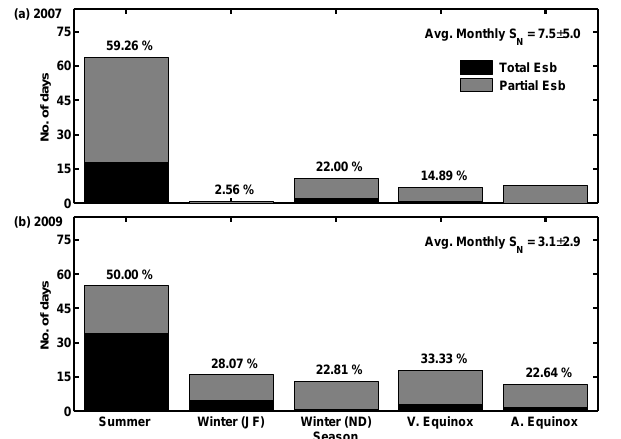
Figure 4. Daily EEJ during (a) 2007 and (b) 2009. The “dash- dotted” curve represents the maximum of monthly average EEJ. Standard deviation in monthly average EEJ is in the range of 11– 24nT (12–23nT) for 2007 (2009). Vertical lines in (b) show the SSW period of 16 January–16